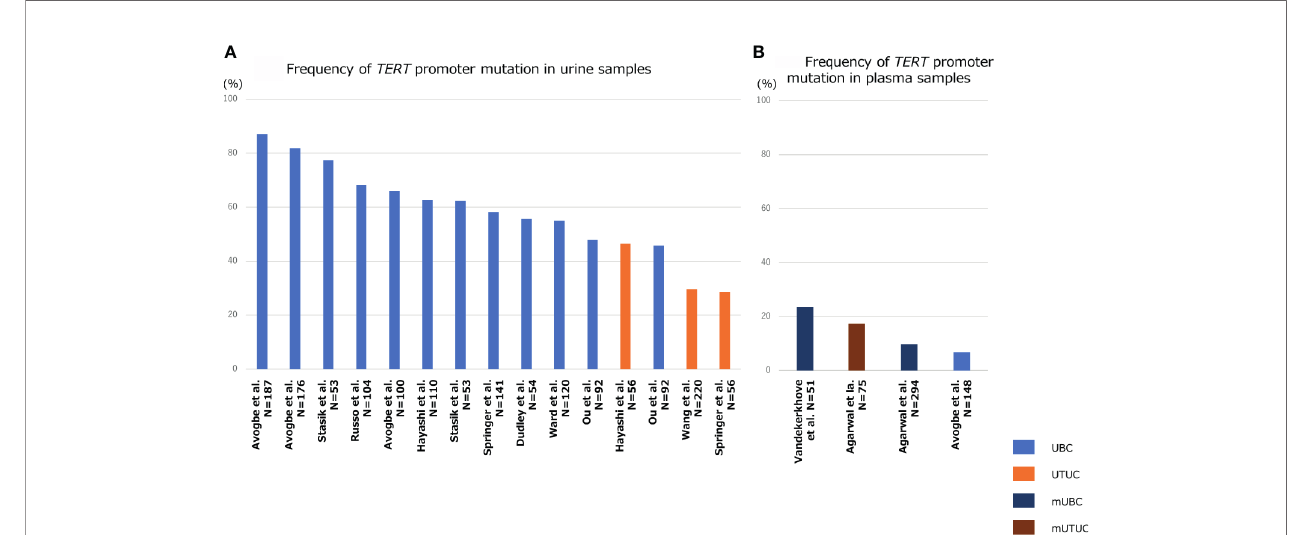
FIGURE 3 | Bar diagram indicating the frequency TERT promoter mutation in liquid biopsy specimens of patients with UBC, UTUC, mUBC (metastatic UBC), and mUTUC (metastatic UTUC). Frequency of TERT promoter mutation in urine samples (A) , and that in plasma samples (B)